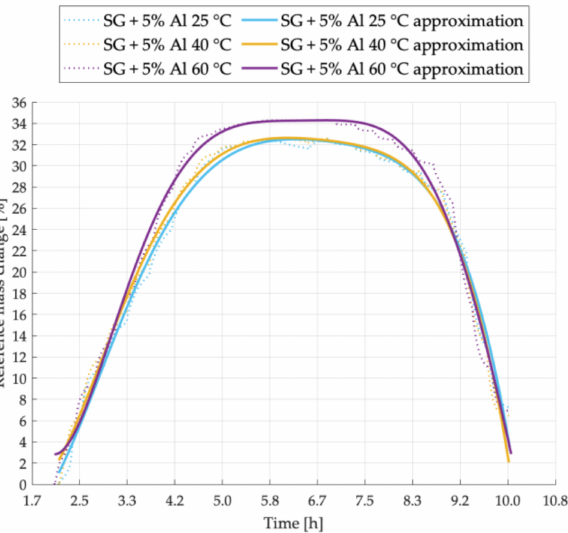
Figure 2. Sorption kinetics graph for SG + 5% Al sample tested at temperatures of 25 ◦ C, 40 ◦ C, 60 ◦